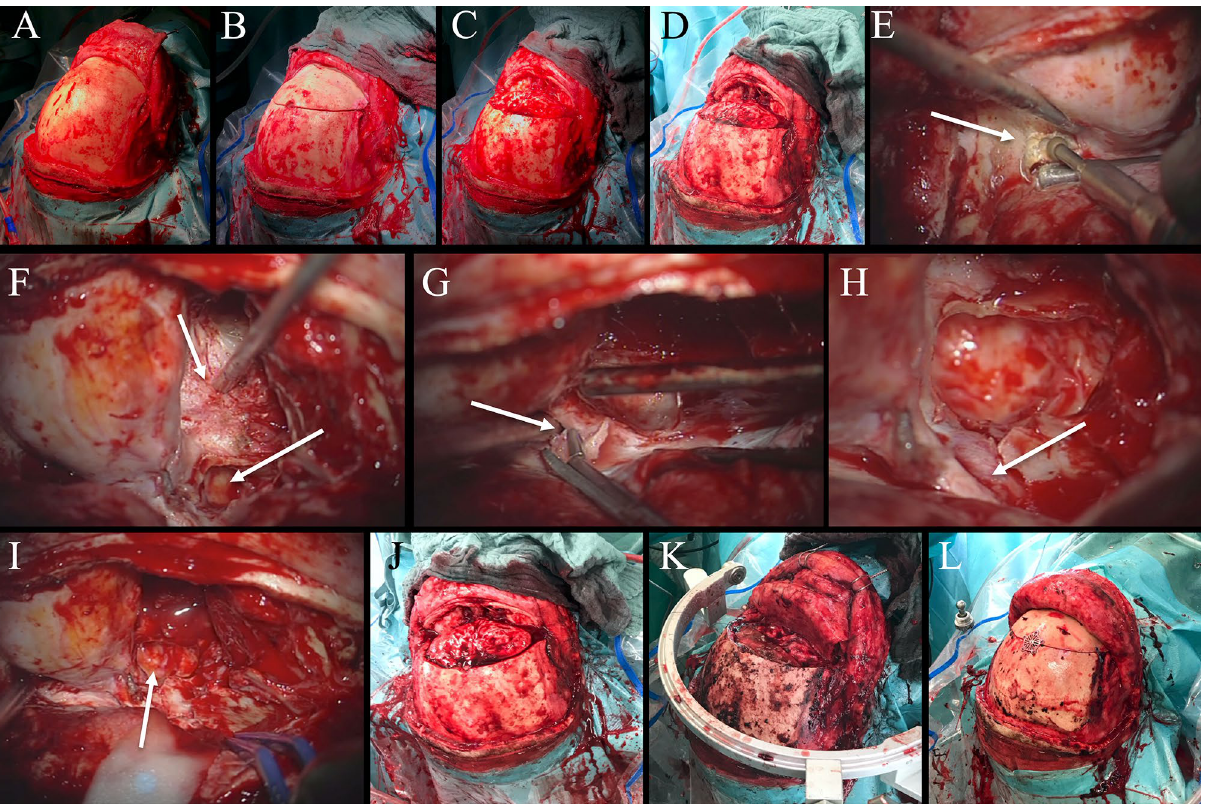
Figure 7. Illustrative case of classic transbasal approach. ( A ) Typical skin incision and preparation of a galea-periosteum flap for later reconstruction. ( B ) Bifrontal craniotomy. ( C , D ) Macroscopic view after bone flap elevation. ( E ) After initial tumor debulking further exploration by resection of lateral sphenoid wing. ( F ) Periorbit and left maxillary sinus exposed. ( G ) Removal of optic strut. ( H ) Exposure of opticocarotid triangle. ( I ) Subfrontal, transethmoidal, transsphenoidal and transmaxillary exposure. ( J ) Macroscopic overview after complete tumor resection. ( K ) Anterior skull base reconstruction is performed by galea-periosteum flap. ( L ) Bone flap re-implantation using thin flaps and